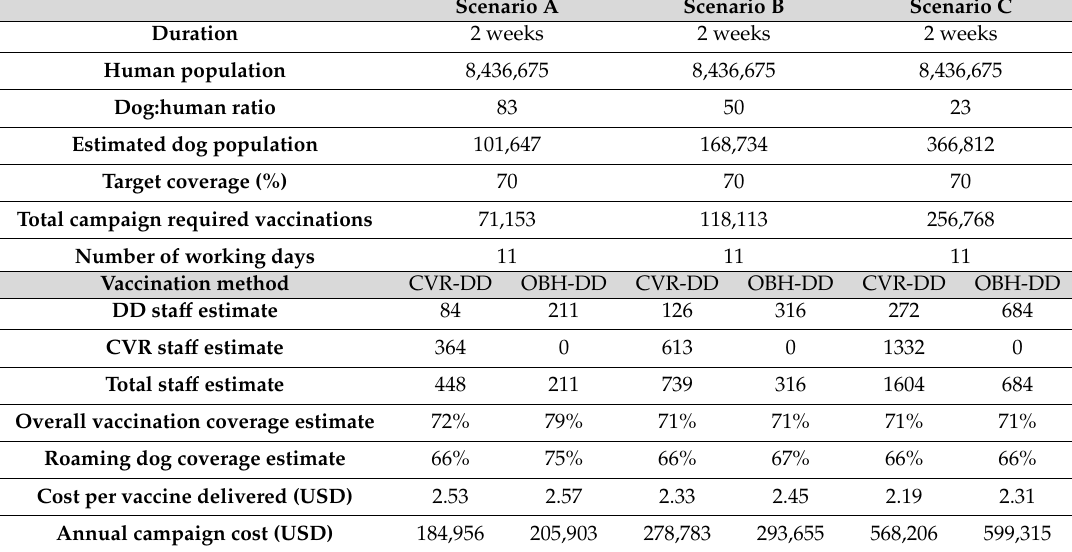
Table 3. Table showing estimations for sta ff and teams required to vaccinate 70% of the dog population in Bangalore City over a two week period using either catch-vaccinate-release (CVR) or oral bait handout methods (OBH) based on three scenarios for potential dog population size. Scenarios for dog population size in Bangalore city were calculated based on best, mean and worse case scenarios for available dog-to-human ratios in Indian urban settings; (A) 83:1, (B) 50:1, (C)